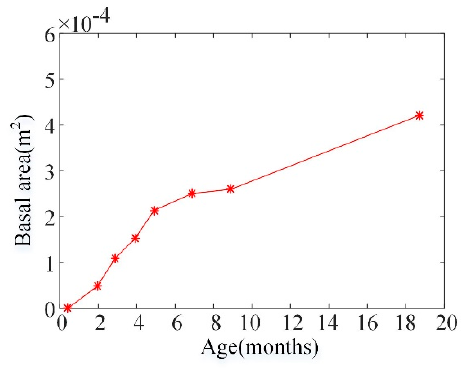
Figure 5. Bottom area of S. balanoides with age.